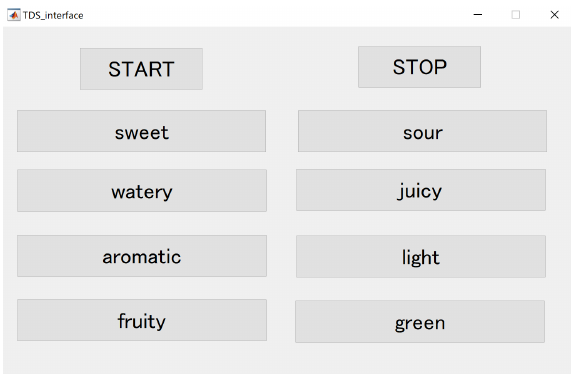
Figure 1. Graphical interface used in a temporal dominance of sensations task. One attribute word is assigned to each